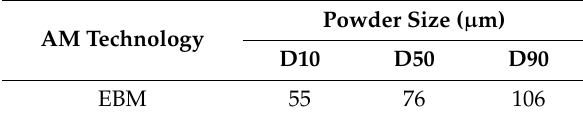
Table 2. EBM Powder size distribution provided by powder producers.